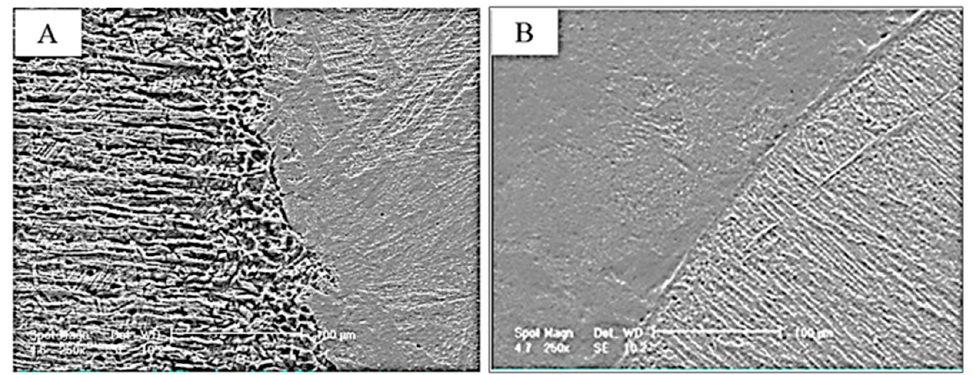
Figure 9. Scanning electron microscopic images for the melting boundary with ( A ) 304 steel, ( B ) carbon steel. Figure 10 represents the simulation results of Cr and Ni diffusion in the molten zone.